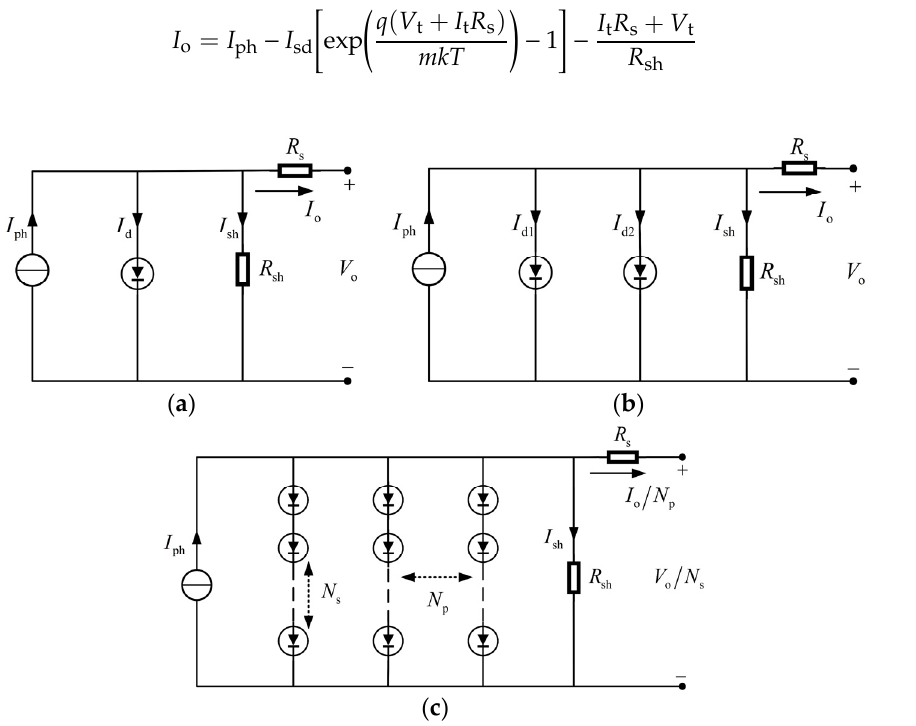
Figure 1. Equivalent circuit diagram of the ( a ) SDM, ( b ) DDM, and ( c ) PMM.